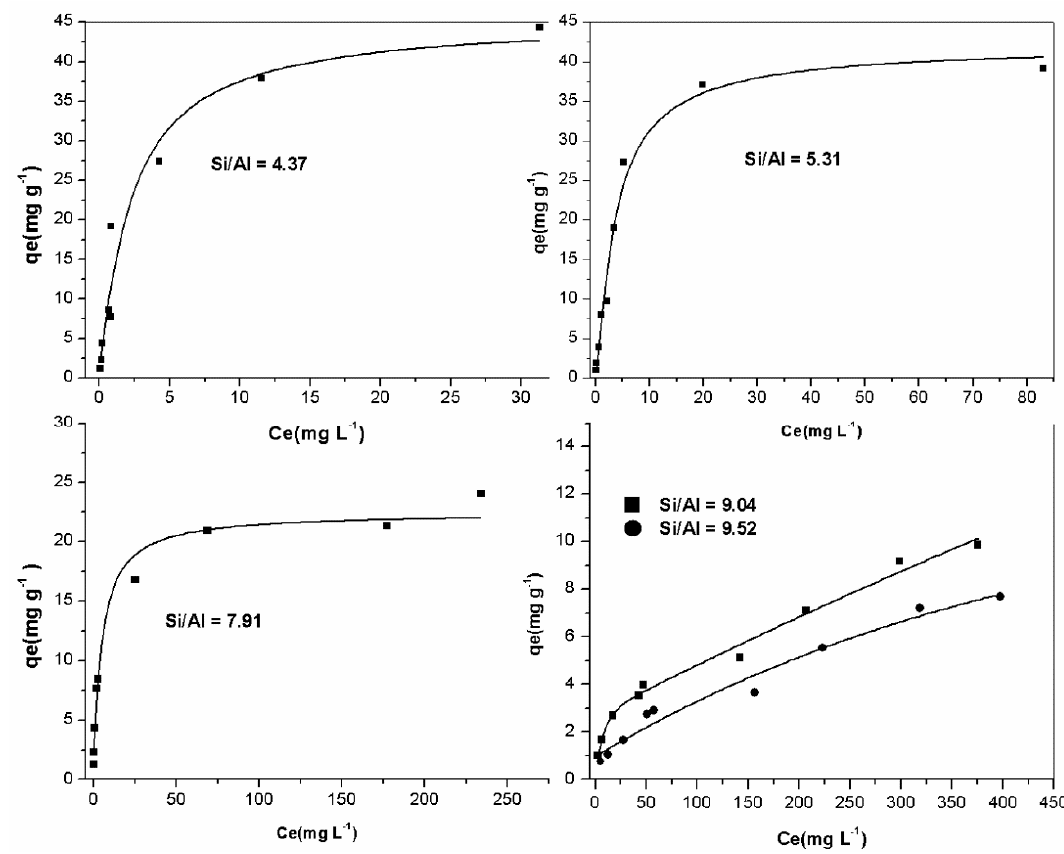
Figure 6. Isotherms for Pb(II) sorption of by non- and acid-modified clinoptilolite-rich tuffs.